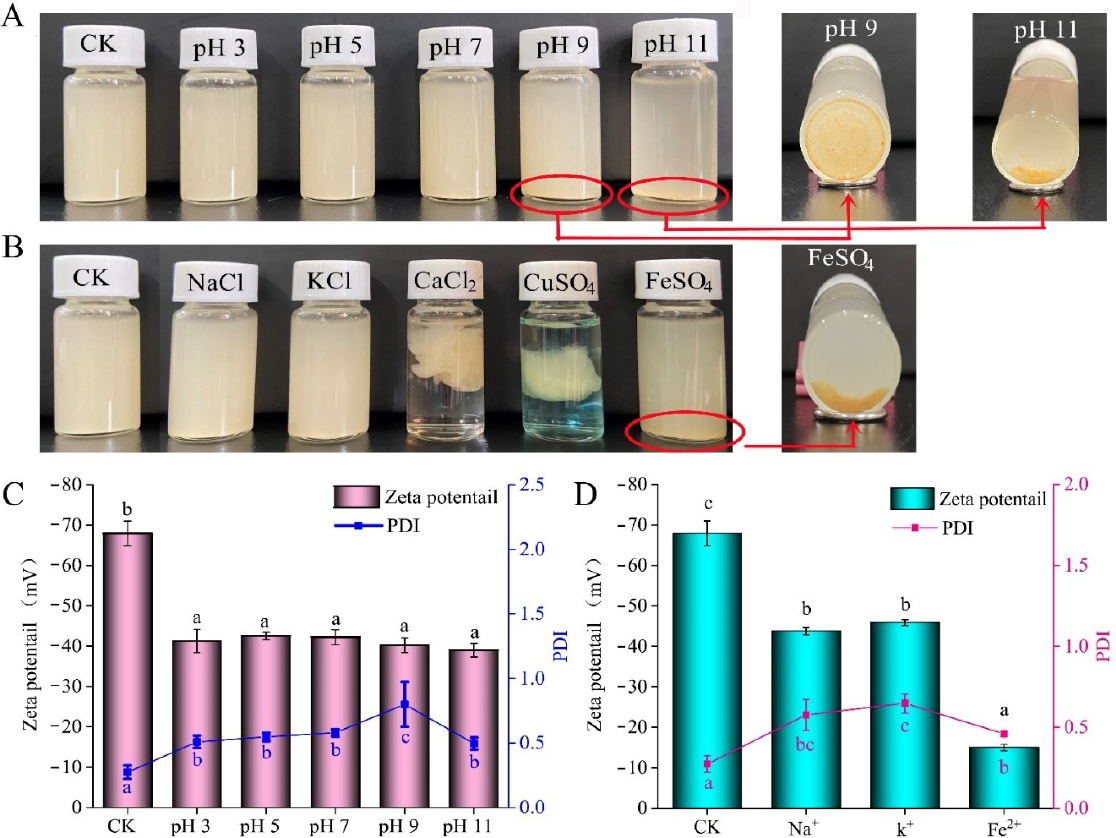
Figure 5. Changes of visual appearance, zeta potential and PDI of APEs after treated at pH 3, 5, 7, 9 and 11 buffers, or 100 mM of Na + , K + , Ca 2+ , Cu 2+ , and Fe 2+ metal ions at room temperature. ( A ) Visual appearance after blended with different pH buffers; ( B ) visual appearance after blended with Na + , K + , Ca 2+ , Cu 2+ , and Fe 2+ , respectively; ( C ) zeta-potential and PDI changes at different pH values (3 – 11); and ( D ) zeta-potential and PDI changes at Na + , K + , and Fe 2+ conditions. All data in ( C , D ) were expressed as the mean ± standard deviation ( n = 3). Different lower-case letters on the bars suggested significant differences ( p < 0.05).